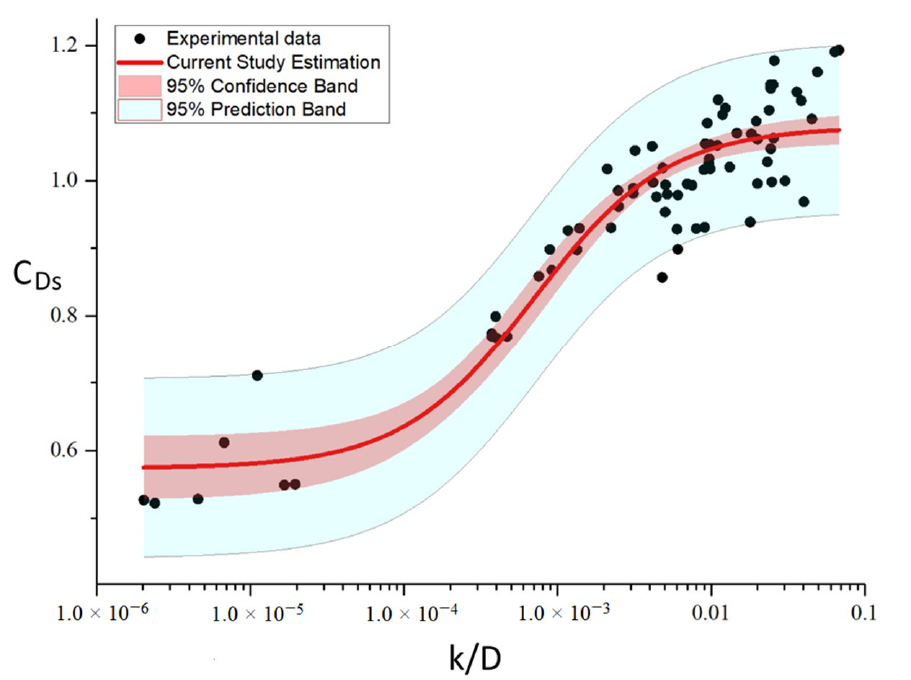
Figure 6. Variation of the C Ds with surface roughness ratio and the 95% confidence intervals (red region) around the fit.